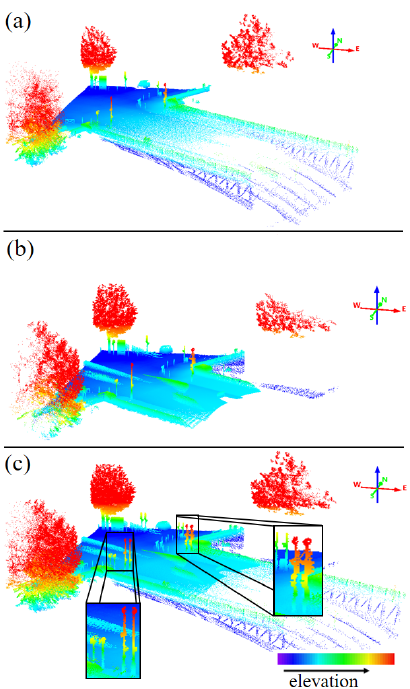
Figure 1. (a) and (b): Two point clouds representing part of the same scene but captured at different times are visualized from a diagonal point-of-view. (c): An overlay of (a) and (b), where the magnified parts highlight the offsets between (a) and